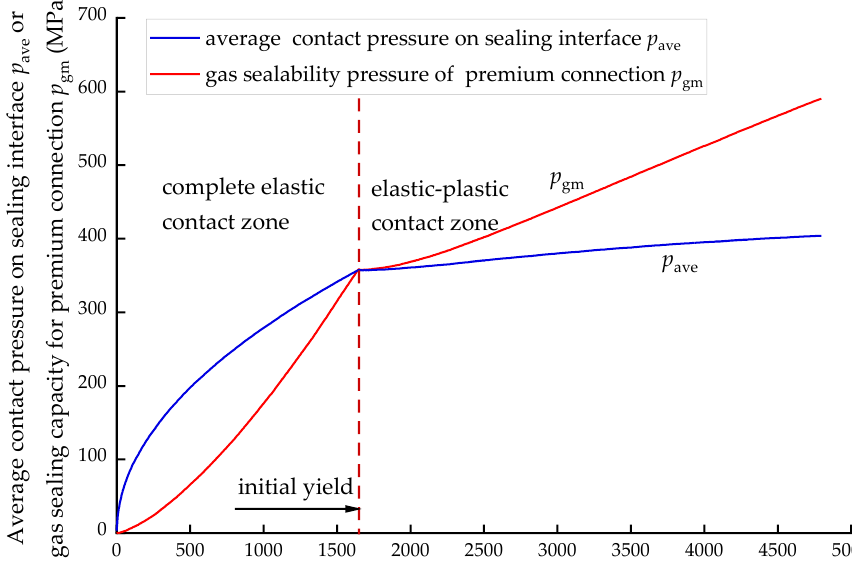
Figure 7. Effects of additional make-up torque from sealing interface on average contact pressure on sealing interface and gas sealing capacity for sphere-type premium connection.